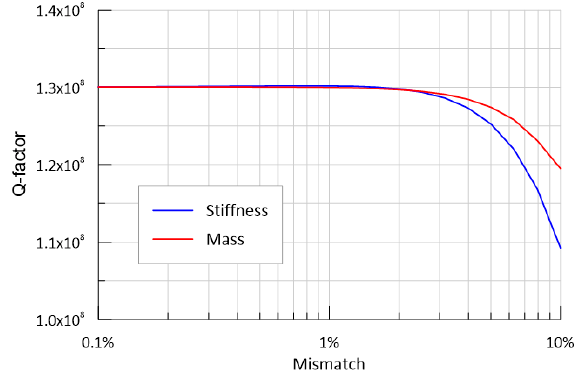
Figure 6. E ff ect of the sti ff ness and mass mismatch on the Q factor. Figure 6. Effect of the stiffness and mass mismatch on the Q factor.